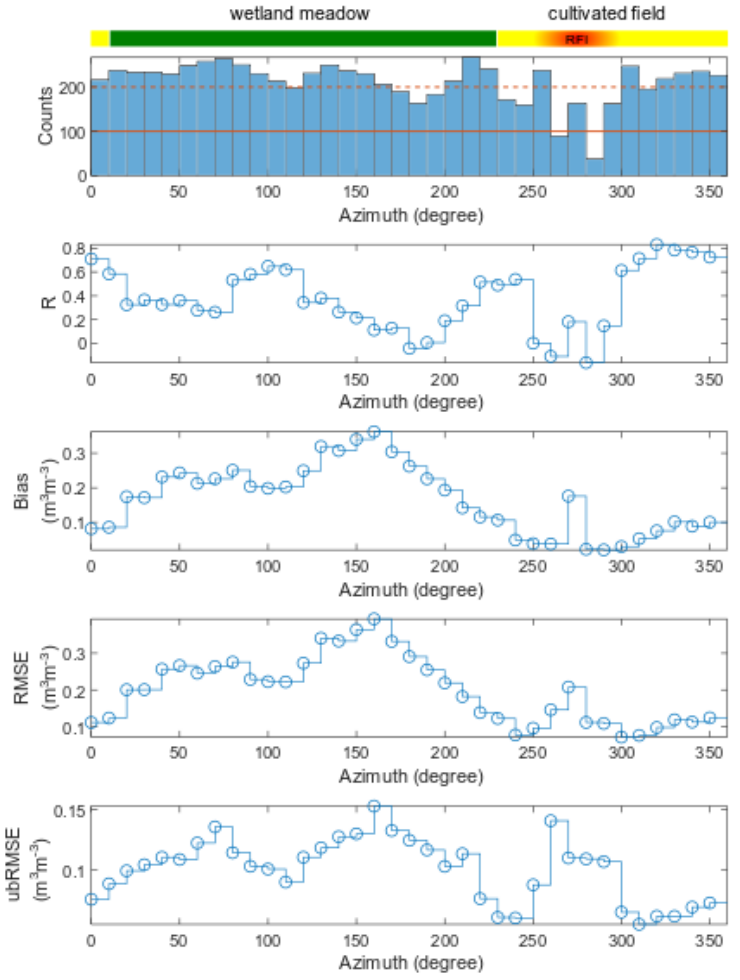
Figure 9. Spatially resolved statistics results for SM (L-MEB SRP modeling) vs. SM probe data. Summary histogram of data counts after data filtering for every azimuth (top) and statistics by means of Pearson correlation coefficient, bias, root mean square error (RMSE), and unbiased RMSE (ubRMSE). Cover type is indicated by a strip on the top of the figure.